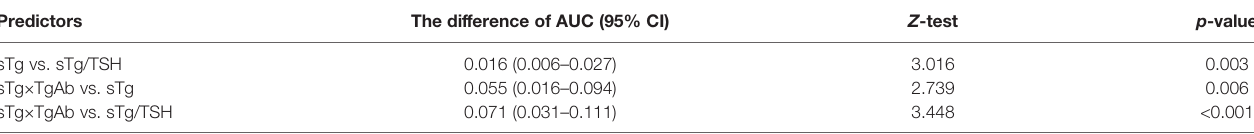
TABLE 3 | Comparison among the ROC curves of preablation sTg, sTg/TSH ratio, and sTg×TgAb product. Predictors The difference of AUC (95%